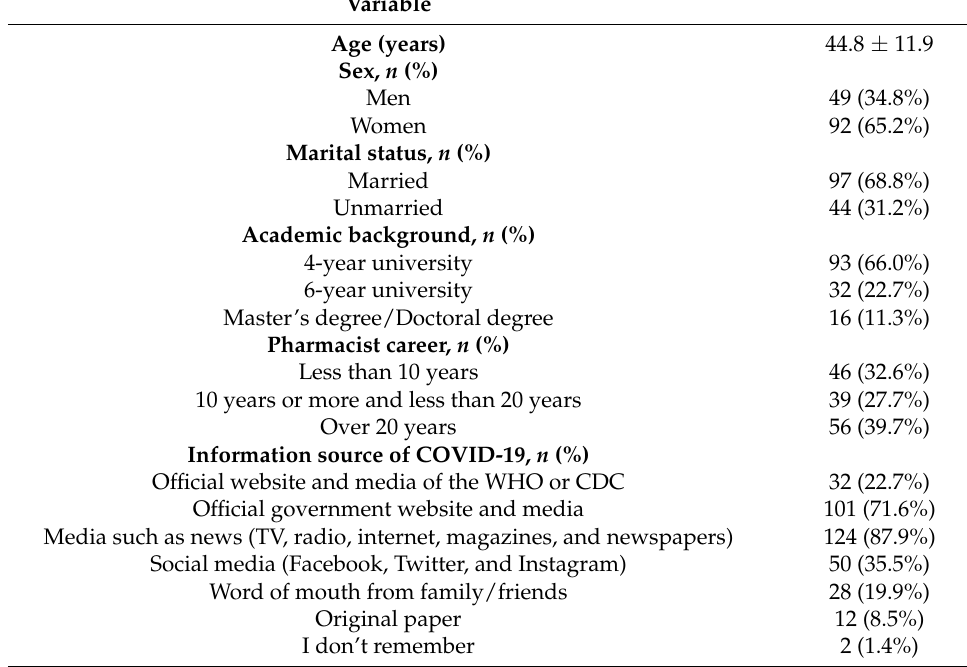
Table 1. Participant characteristics ( n =